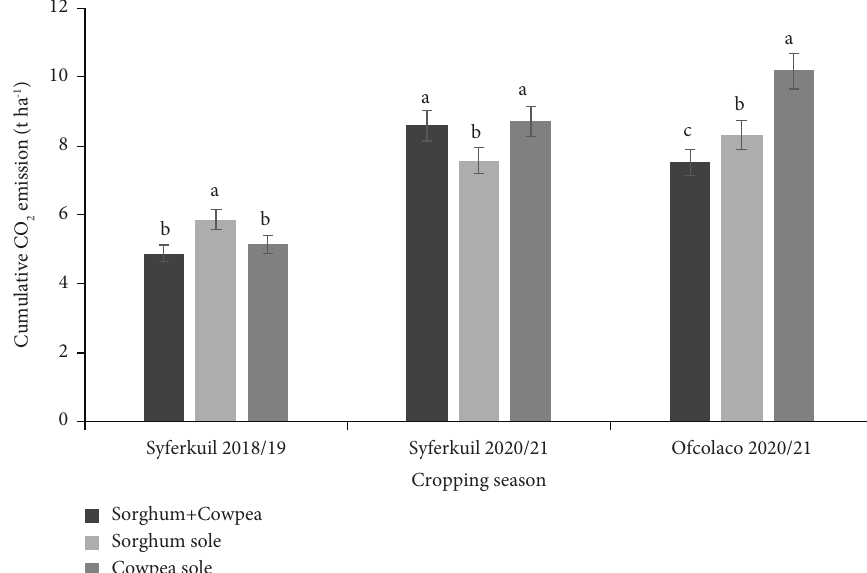
Figure 14: Cumulative CO 2 emission rates of sorghum and cowpea in binary and sole cultures at Syferkuil and Ofcolaco during the 2018/19 and 2020/21 cropping seasons.